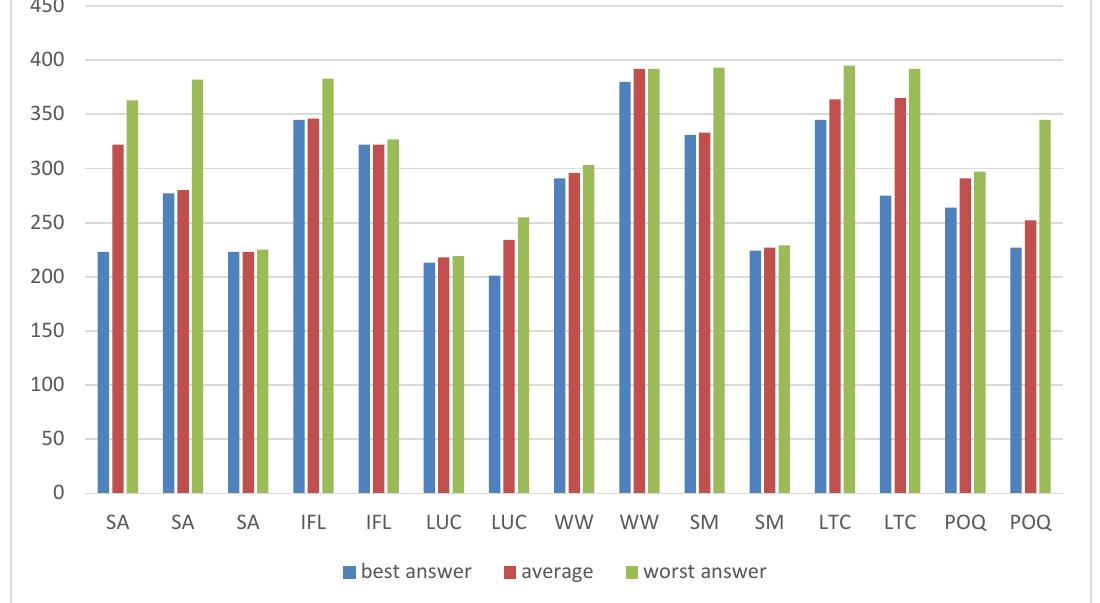
Fig. 4. The comparison chart for 60